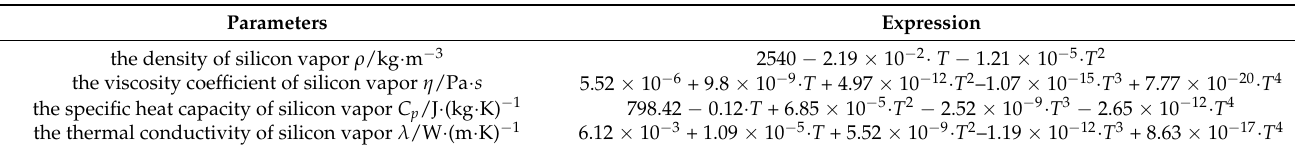
Table 1. The velocity field under the condition of the maximum shock wave acceleration is analyzed. The velocity distribution in different spatial positions is shown in Figure 6, and here we refer to the velocity distribution in different positions of the axial z at r = 0. The distribution of the velocity field is different. Figure 6a,b shows the distributions of shock wave velocity with D ms = 226.13 J/cm 2 , ∆ t = 0.8 ms at 807 µ s and D ms = 301 J/cm 2 , ∆ t = 2.4 ms at 2407 µ s, respectively. As shown in Figure 6a, the maximum velocity region is mainly concentrated on the silicon surface in case 1. The recoil pressure of the ms-ns CPL- induced shock wave propagates to the silicon surface. The convection between the recoil pressure and silicon vapor overflowing from the silicon increase the velocity of the plasma near the silicon surface. Hence, the maximum velocity region is mainly concentrated on the silicon surface. However, two relatively large velocities distribute on the target surface and the shock wave front in case 2, which is shown in Figure 6b. This is because the ms laser-induced plasma as a propagation medium can accelerate the shock wave velocity. To more clearly compare the changes of velocity values in different axial (z) positions of r = 0, we add a probe in the process of solving the model by Comsol to accurately obtain the velocity values at different axial (z) positions of r = 0, and the curves drawn by these velocity values are shown in Figure 7. It shows that the shock wave velocity in case 1 and case 2 are approximately equal. But the difference of plasma velocity between case 1 and case 2 near the target surface is 200 m/s. This is caused by the state of ms laser-induced plasma before the ns laser